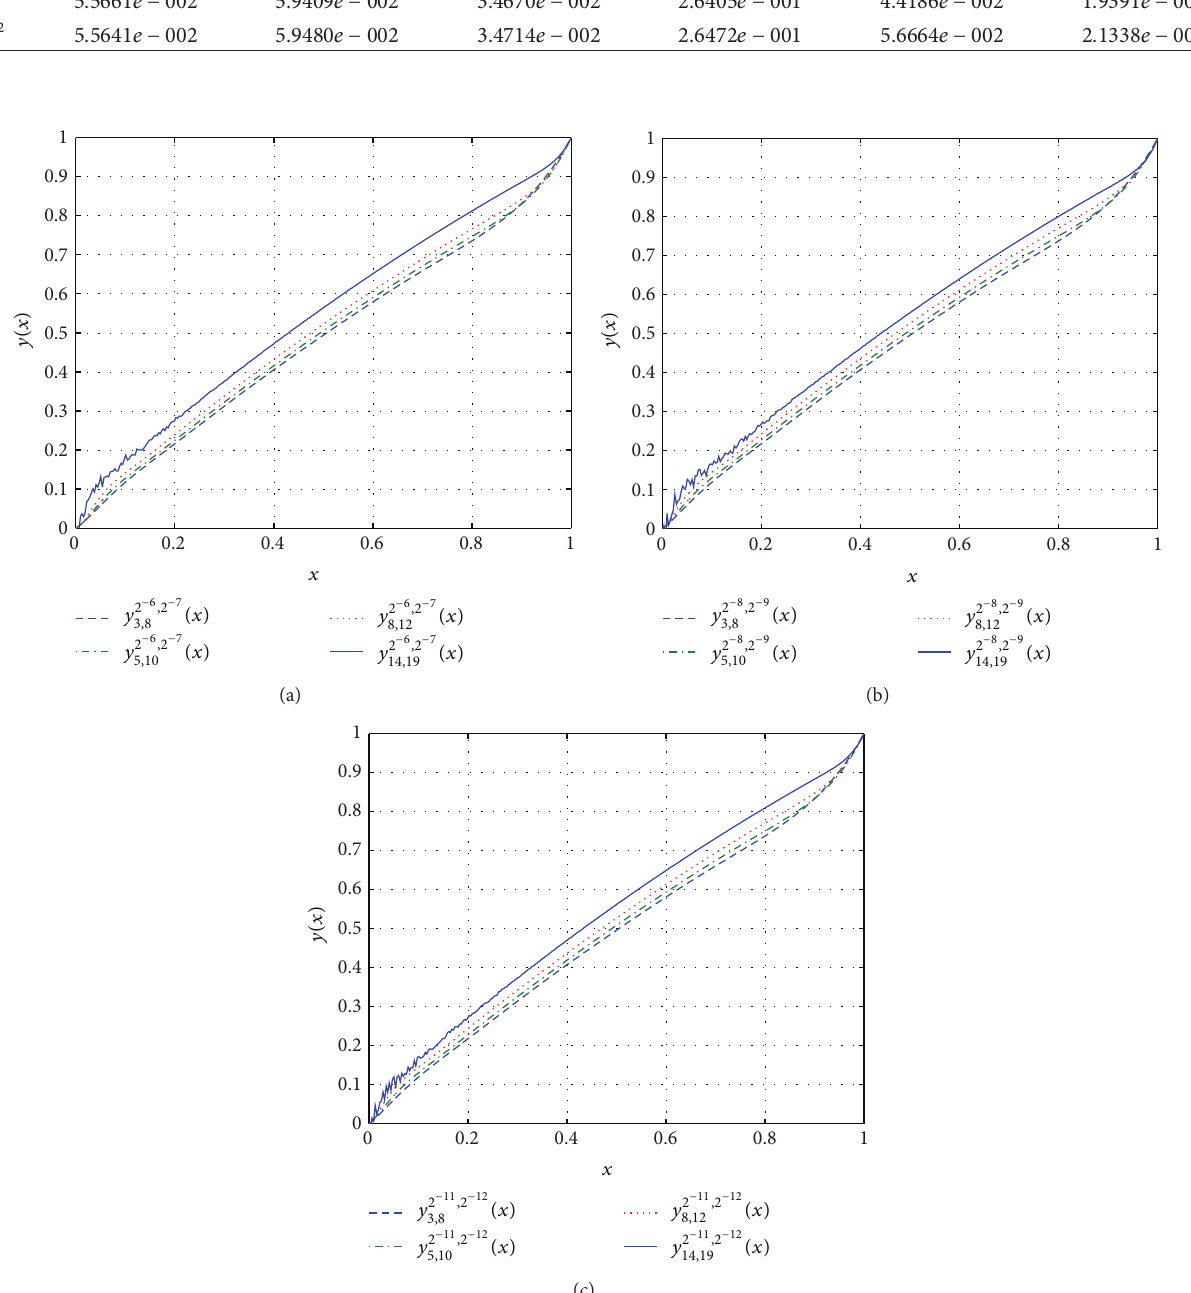
Figure 1: For 𝛿 = 0.5𝜀 and various values of 𝑁 and 𝑀 of (38), (a) graph of the approximate solutions for 𝜀 = 2 −6 , (b) graph of the approximate solutions for 𝜀 = 2 −8 , and (c) graph of the approximate solutions for 𝜀 = 2 −11